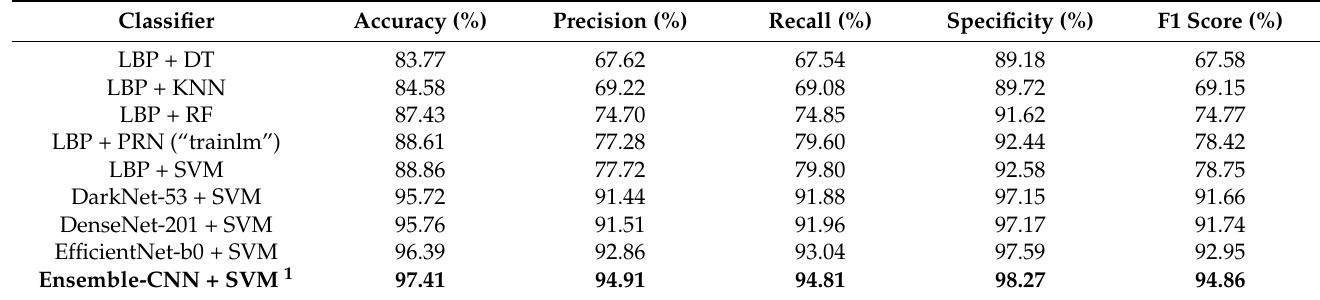
Table 6. Topmost classification performance provided by different classifiers.